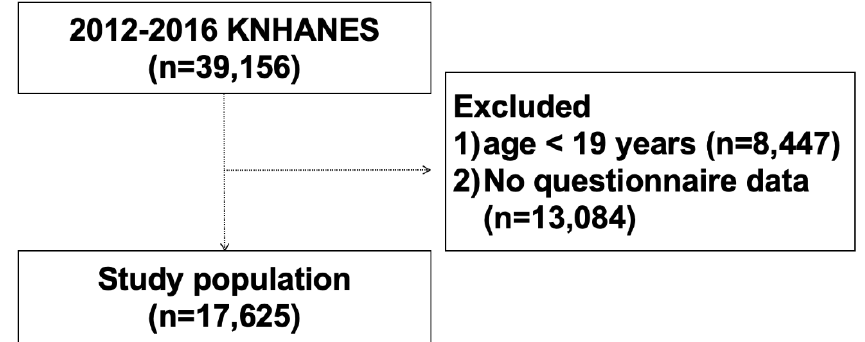
Figure 1. Flow chart showing the study population. KNHANES, Korea National Health and Nutrition Examination Survey .